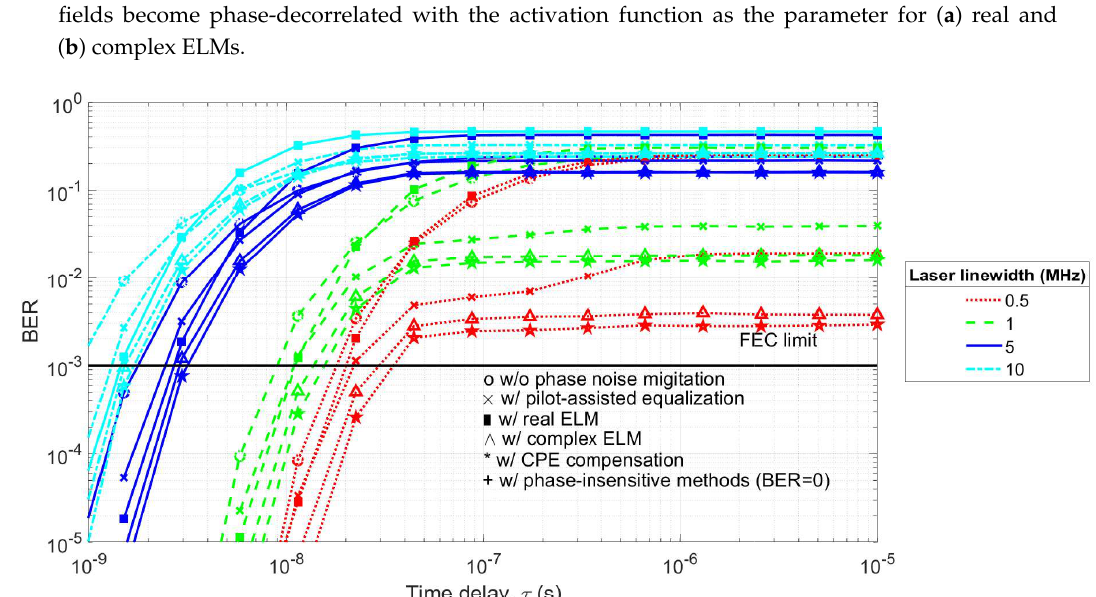
Figure 7. For different phase noise mitigation methods, the BER in terms of the amount of phase correlation between the beating tones with the laser linewidth as the parameter and without